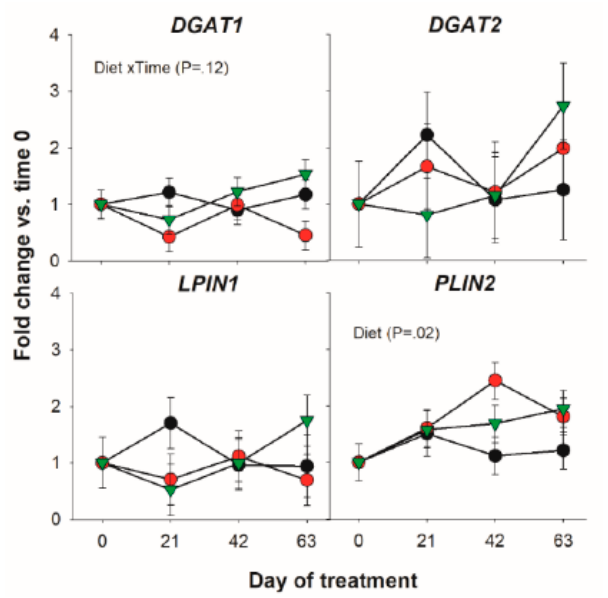
Figure 3. Effect of olive oil (OO) or hydrogenated olive oil (HVO) on transcripts coding for proteins involved in triacylglycerol synthesis. Reported in the graph are the p -value of the overall significant effect of Diet and tendency for the effect of Diet x Time interaction.